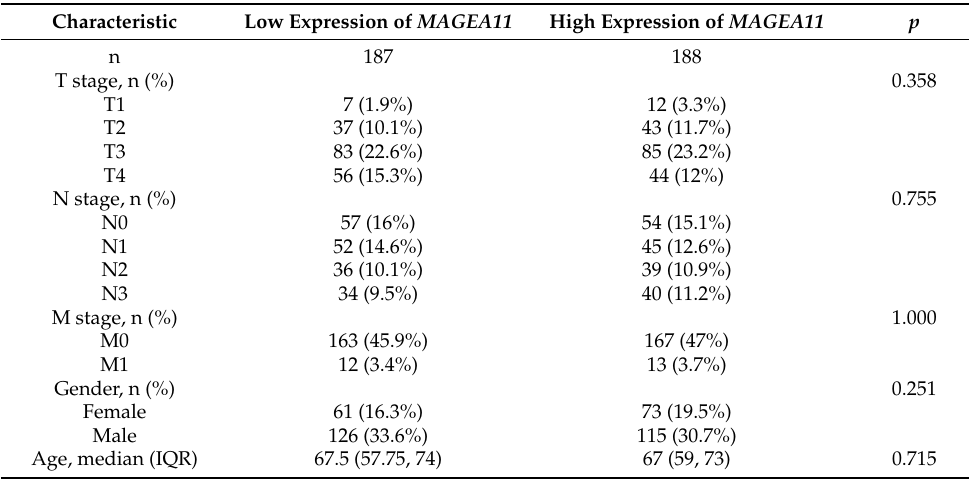
Table 1. TCGA Clinical Baseline Data Sheet for STAD Patients.